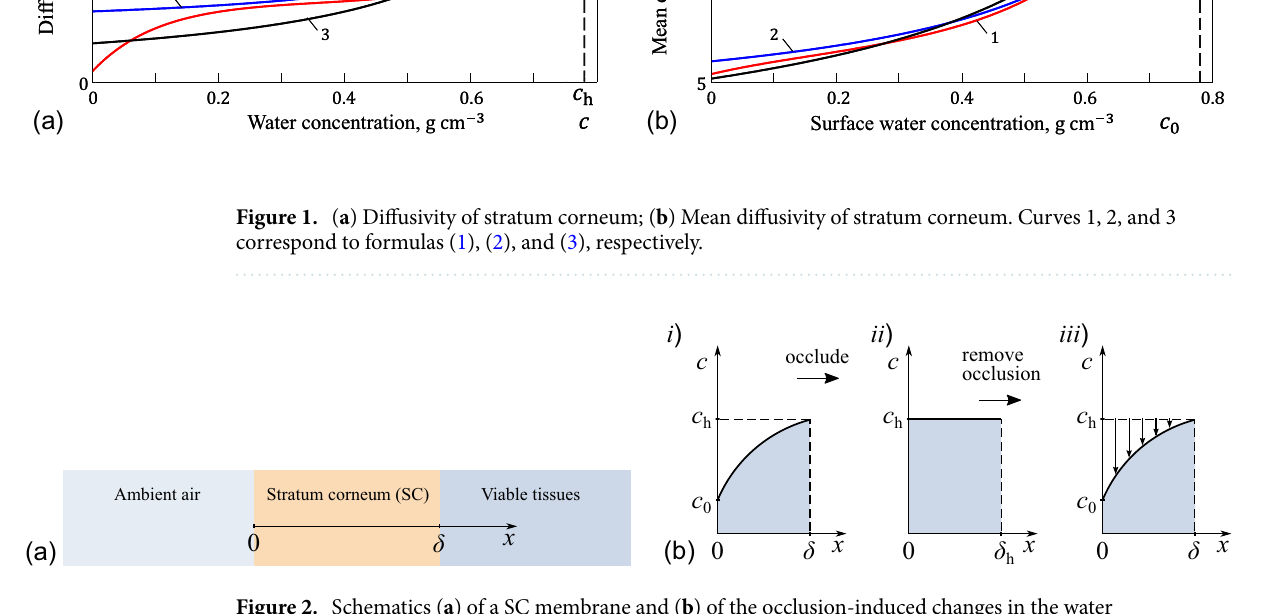
Figure 2. Schematics ( a ) of a SC membrane and ( b ) of the occlusion-induced changes in the water concentration profile across the stratum corneum (after 2